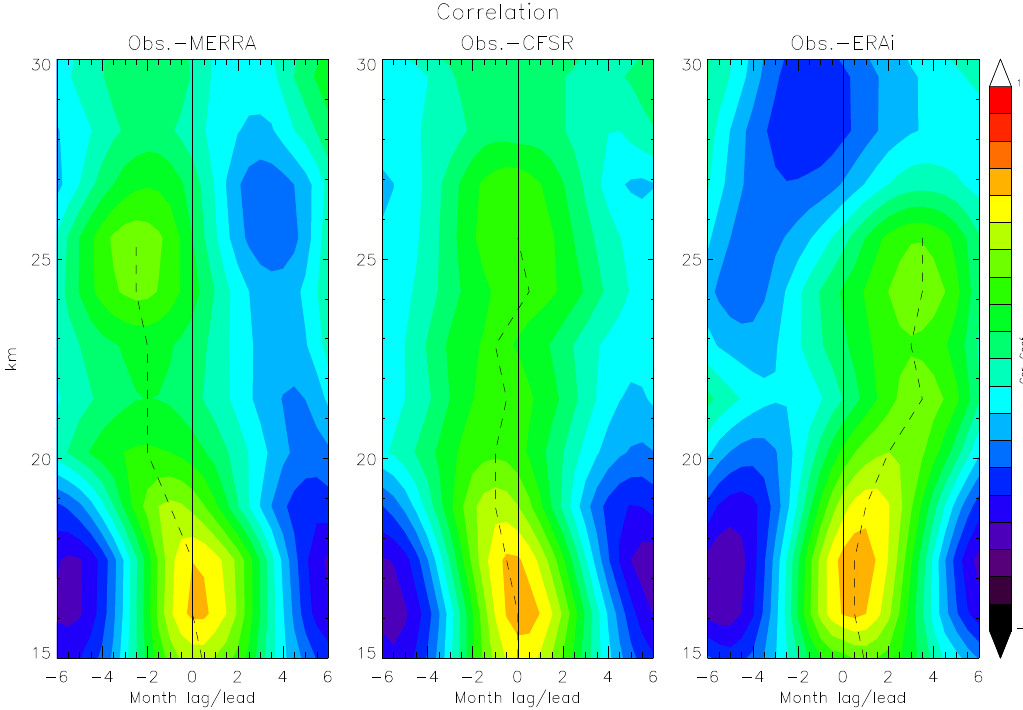
Fig. 8. Correlation of MERRA, CFSR and ERAi results with observations after phase shifting the observations by number of months as indicated. Dashed line shows the peak correlation.